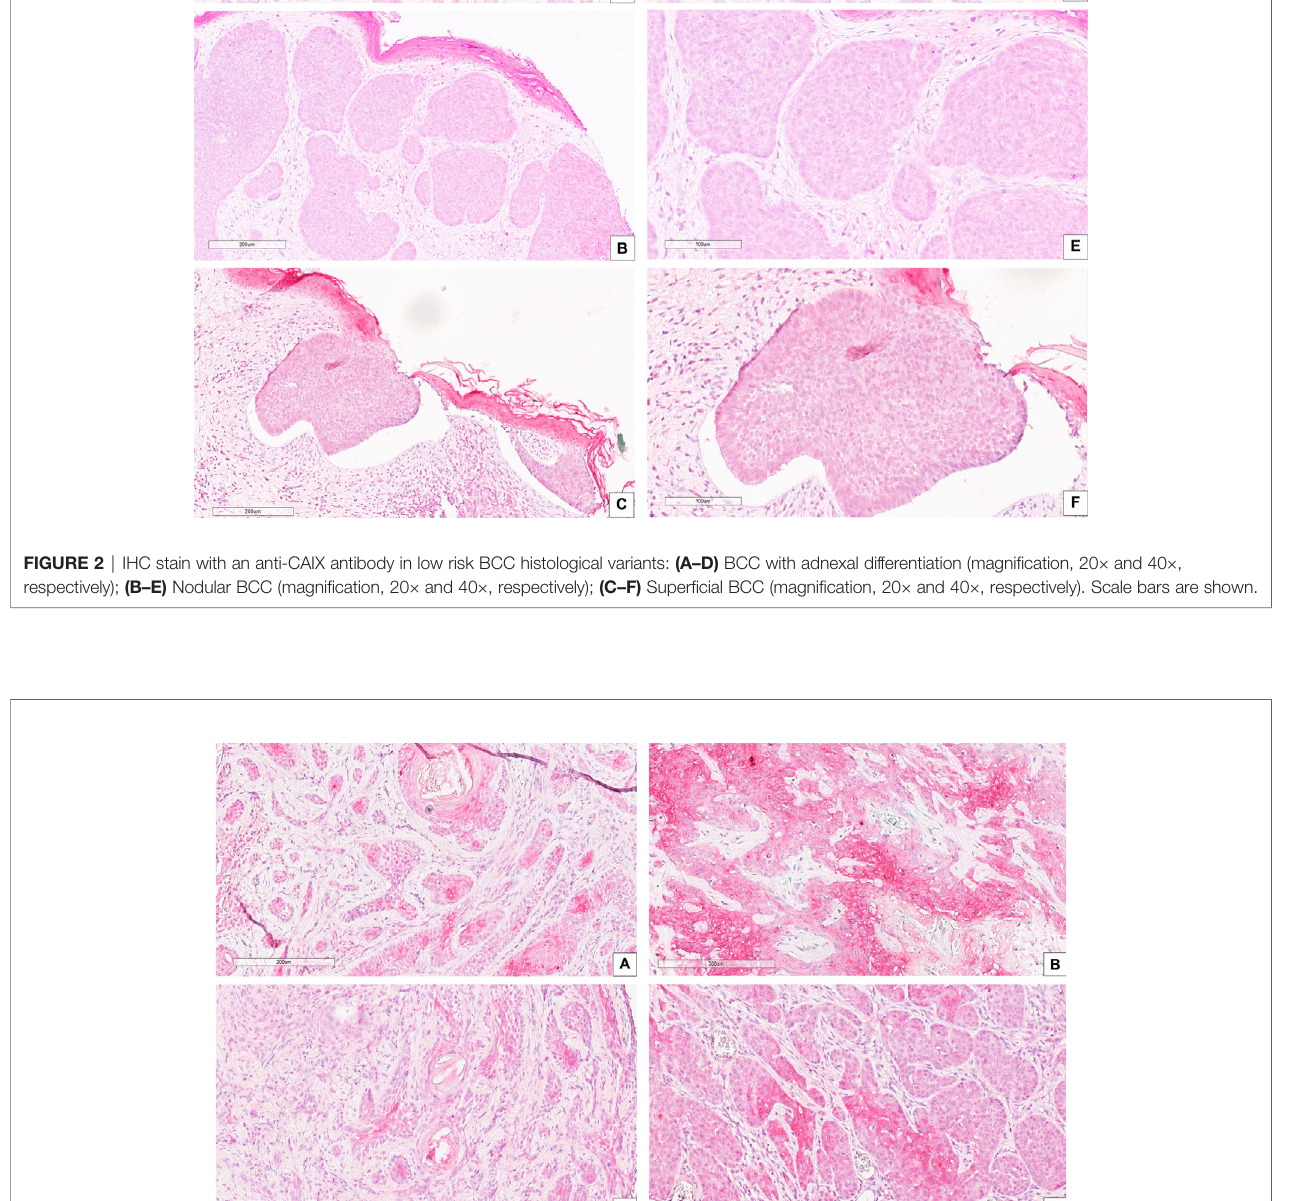
Frontiers in Oncology |